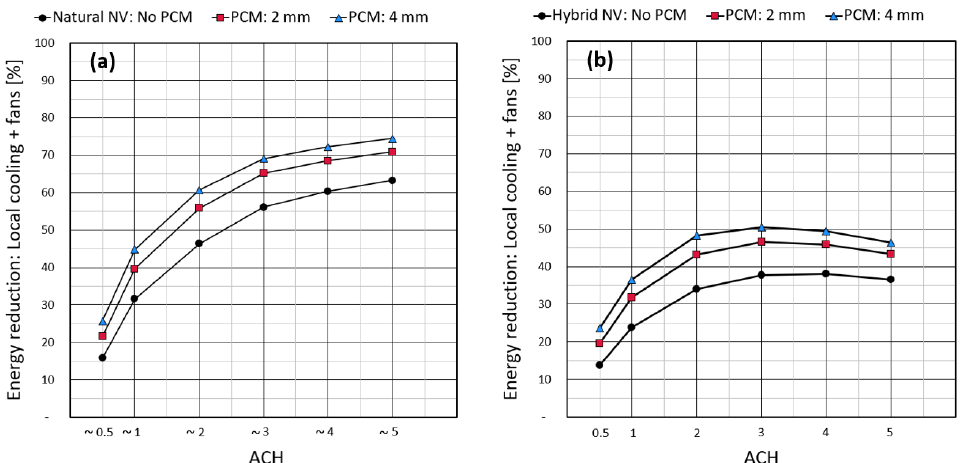
Figure 11. Total energy reduction for the building. ( a ) Natural NV strategy. ( b ) Hybrid NV